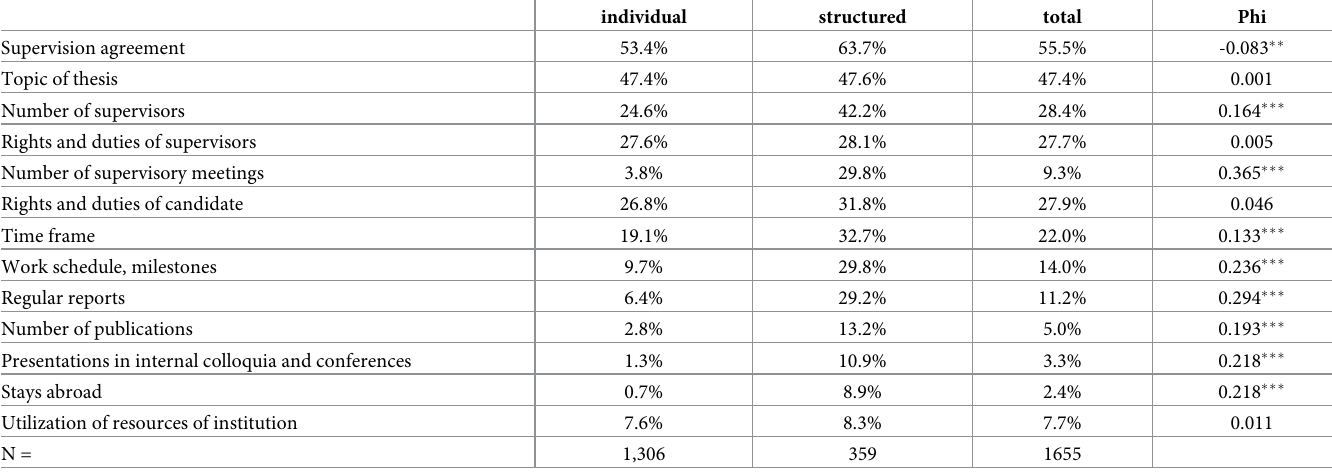
Table 6. Supervision agreement and its contents.